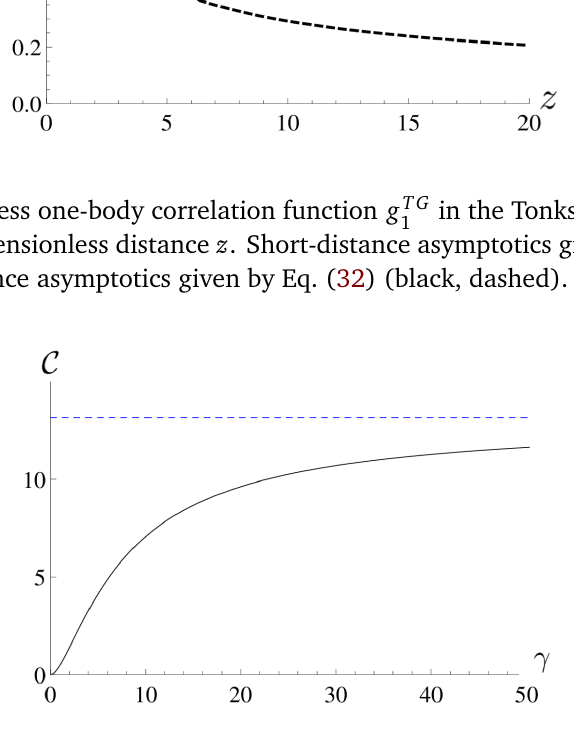
Figure 7: Dimensionless Tan’s contact (cid:67) as a function of dimensionless interaction strength γ (solid, black) and its value in the Tonks-Girardeau limit, (cid:67) TG = 4 π 2 / 3 (dashed,